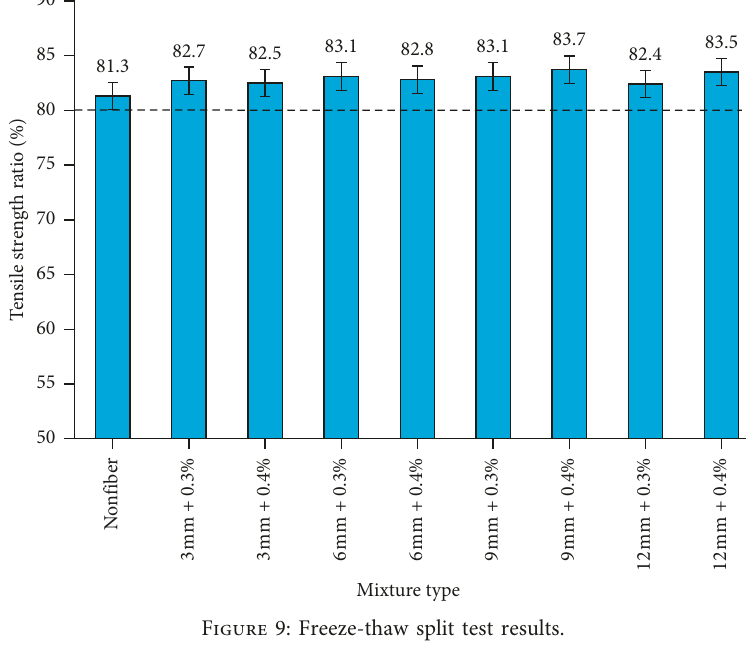
Figure 9: Freeze-thaw split test results.